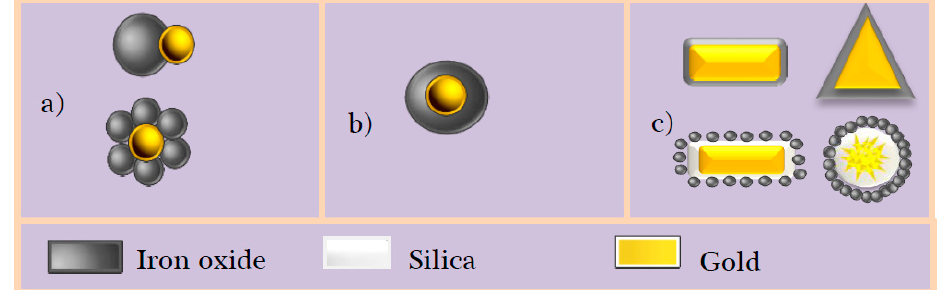
Figure 11. Some structures of Au-Fe 3 − x O 4 Nanostructures (AFNSs): ( a ) dumbbells and core-satellites; ( b ) spherical core-shell and ( c ) non-spherical core-shell.